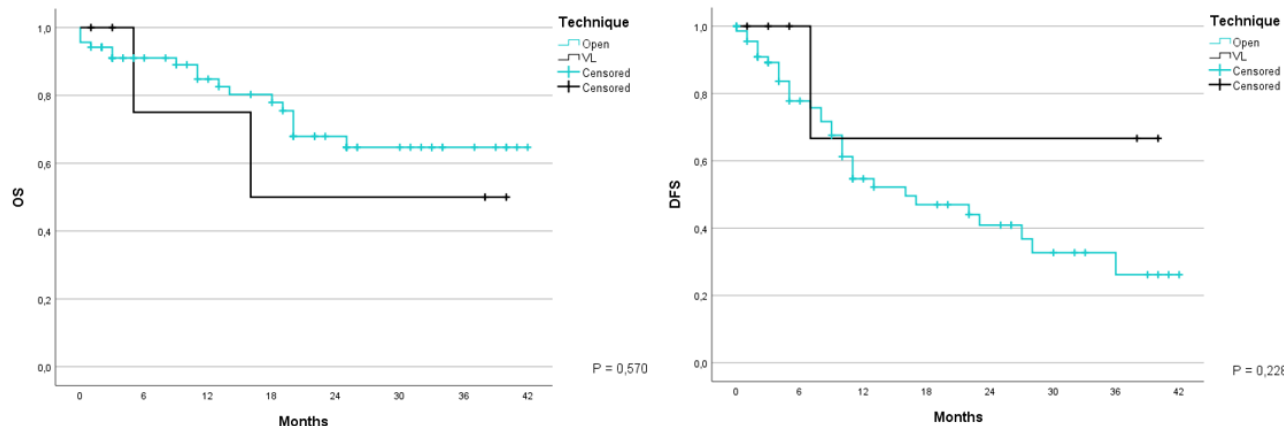
Figure 7. Kaplan-Meier Curve for OS and DFS in patients who underwent liver resection for CRLM stratified according to type for surgical technique used. OS: Overall Survival; DFS: Disease Free Survival; CRLM: Colorectal liver metastasis. Open; VL-video laparoscopy.